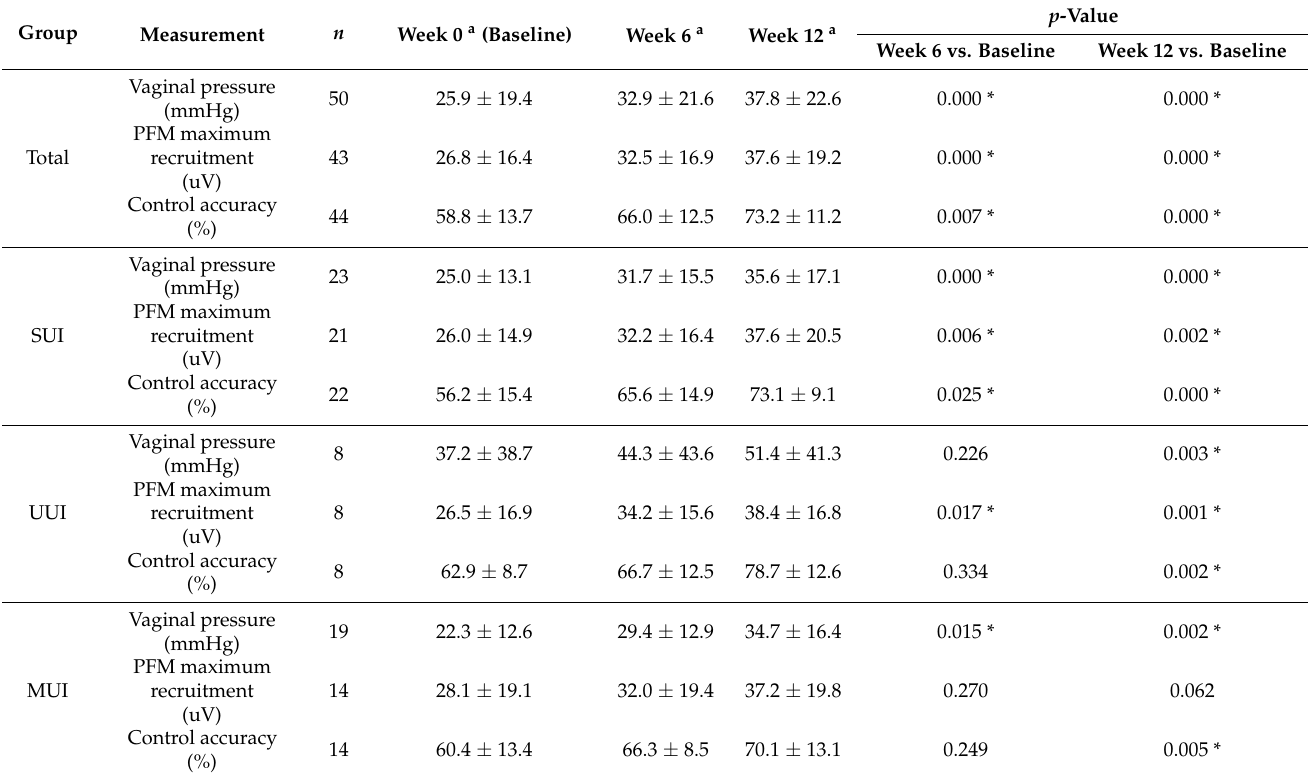
Table 2. Comparisons of measures between baseline vs. 6 weeks post-treatment and vs. 12 weeks post-treatment.